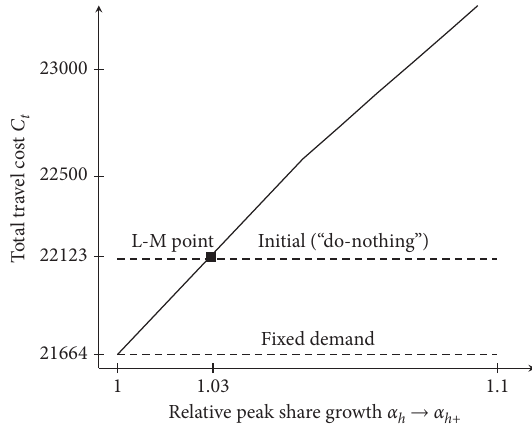
Figure 9: Travel costs C t against peak-hour share